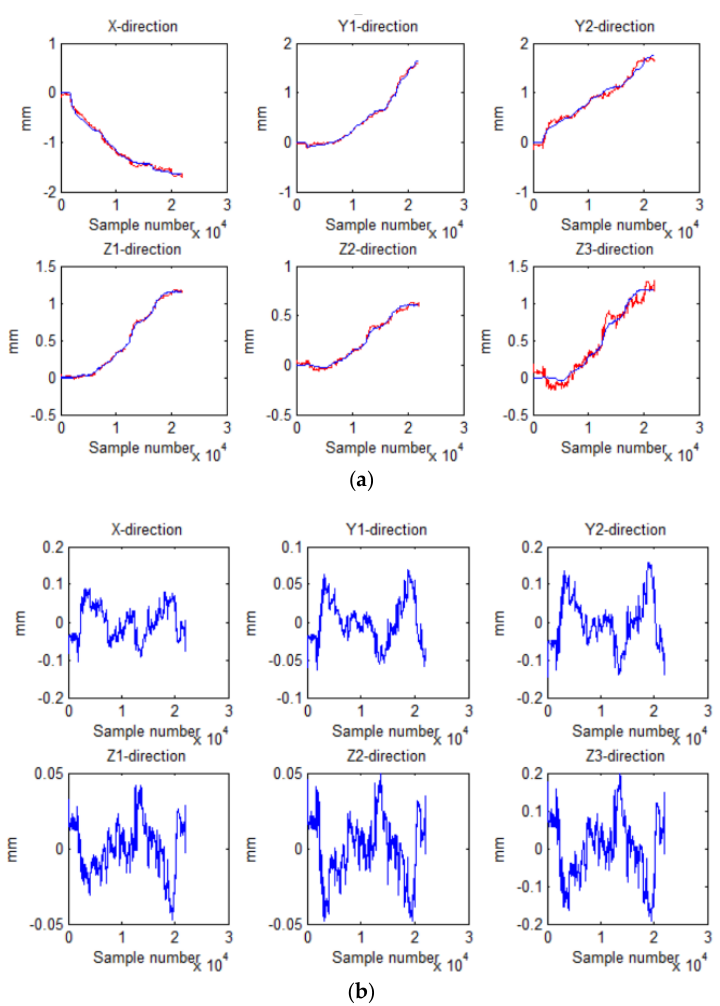
Figure 8. Displacement of the Hall sensors deduced by of the displacement of laser sensors and the least squares method: ( a ) displacement obtained by two ways; ( b ) difference between the two displacements. Further, the multidimensional fitting was performed, and the displacement of the Hall sensors (blue), deduced by the displacement of laser sensors displacement, was compared with the Hall displacement (red) solved by the least squares method, as shown in Figure 9a. And Figure 9b shows the errors. The maximum error in both the X and the Y 1 direction was ±0.05 mm, in the Y 2 direction ±0.06 mm, in the Z 1 direction ±0.04 mm, in the Z 2 direction ±0.02 mm, and in the Z 3 direction ±0.12 mm. After comparison, it can be found that the error of the improved least squares method was much smaller than that of the previous method. The Hall displacement deduced by the laser sensor was closer to the displacement solved by the least squares method. Therefore, we choose multidimensional fitting to obtain parameters A and B .